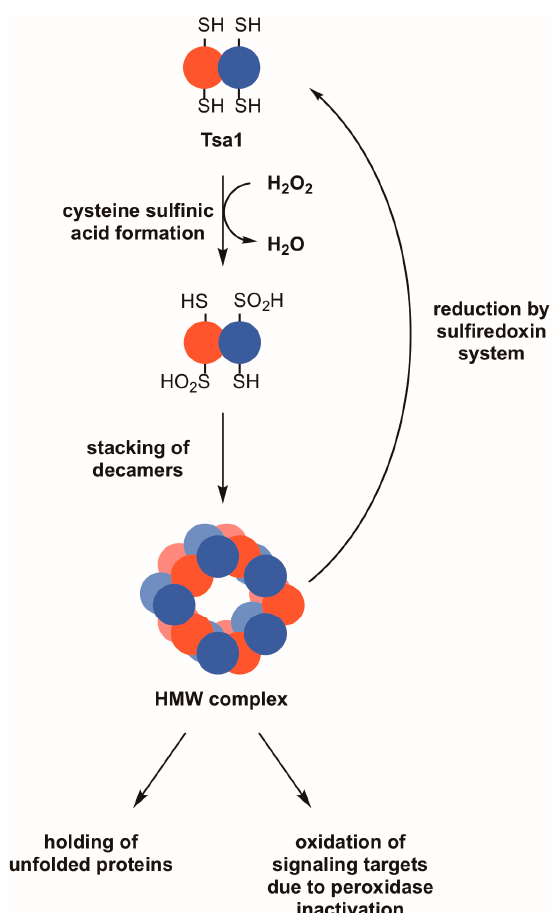
Figure 2. Reversible hyperoxidation of Tsa1 and other 2-Cys peroxiredoxins leads to the acquisition of molecular chaperone activity and may result in the oxidation of other proteins. During periods of pronounced oxidative stress, the thiol group in the peroxidatic cysteine of Tsa1 and similar peroxiredoxins can form cysteine sulfinic acid (–SO 2 H). This hyperoxidation event can cause Tsa1 decamers to oligomerize into high molecular weight (HMW) complexes, which are thought to possess molecular chaperone activity as holdases. An indirect effect of Tsa1 inactivation is that other proteins that are normally less sensitive to peroxide become oxidized. Hyperoxidized Tsa1 can be restored to its functional form by the combined actions of the sulfiredoxin and thioredoxin systems. Hyperoxidation of peroxiredoxins is postulated to have both direct and indirect functional consequences. The hyperoxidized form of peroxiredoxins either remains in a decameric state or oligomerizes further to a high molecular weight (HMW) state (e.g., a 20-mer consisting of two stacked decamer rings) [56,57]. Regardless of the subunit composition, the large complex transitions from an active peroxidase involved in peroxide detoxification to a molecular chaperone with holdase activity (Figure 2) [56–58]. Tsa1 associates with several ribosomal proteins following proteotoxic stress, suggesting that it prevents these subunits from undergoing stress-induced aggregation and/or decreases unwanted oligomerization of nascent peptides that emerge from the ribosome under these conditions [59]. An alternative view posited for the hyperoxidation of peroxiredoxins is that, with their inactivation, peroxides are more available to oxidize other intracellular target proteins as a means of redox signaling (Figure 2) [51]. This has been suggested because typical 2-Cys peroxiredoxins from eukaryotes are more susceptible to hyperoxidation, suggesting that, when they are in their inactive, sulfinic acid forms, more peroxides are available to oxidize other protein targets in a cell [51]. There is only limited biological evidence to support the latter ‘floodgate’ model wherein